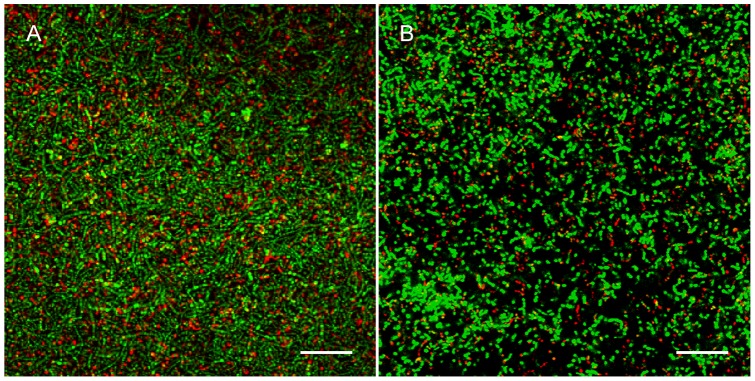
Viability of the organisms in the biofilms.Biofilms grown without OPN (A) and with OPN in the medium (B) were stained with BacLight. Viable bacteria appear green and membrane-compromised bacteria red. The presence of OPN in the medium did not affect bacterial viability in the biofilms. Bars  = 20 µm.